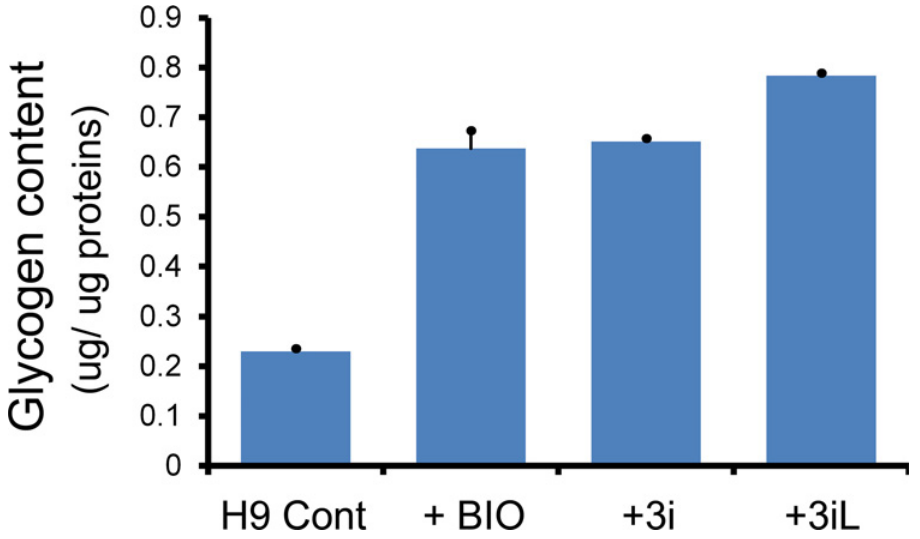
Fig 7. Glycogen colorimetric assays of H9 NANOG reporter (H9 hNanog-pGZ) cells under na ï ve hPSC growth conditions. The reporter cells (abbreviated as H9 Cont) were treated with GSK3i (BIO), 3i (GSK3i + MEKi + BMP4i), and 3iL (3i + LIF) as described in Materials and Methods. Glycogen colorimetric assays were performed under the same condition as described in Fig